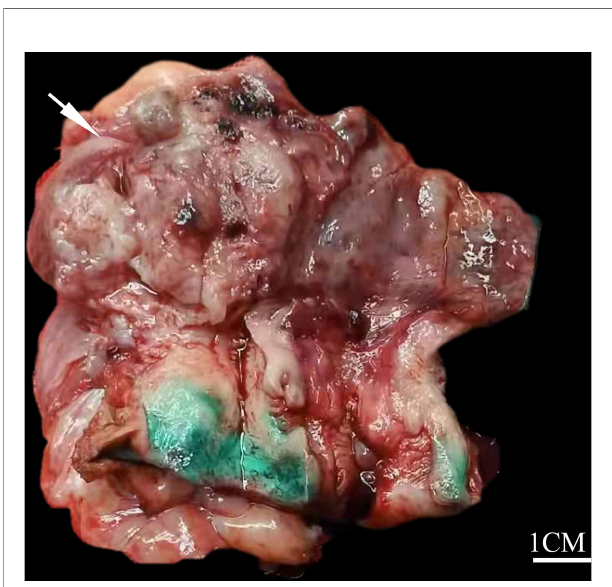
FIGURE 1 | Gross fi ndings of uterine corpus MLA. The tumor presents as a solid and soft mass with white to gray coloring (white arrow), protruding into the endometrial cavity (case